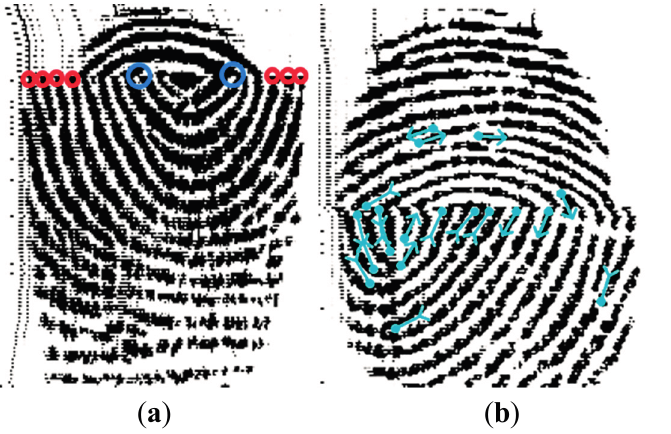
Figure 2. ( a ) Truncated fingerprint contains two types of feature points including pseudo bifurcation nodes (blue circle) and pseudo ridge ending points (red circle); ( b ) Truncated fingerprint possesses minutiae points found by